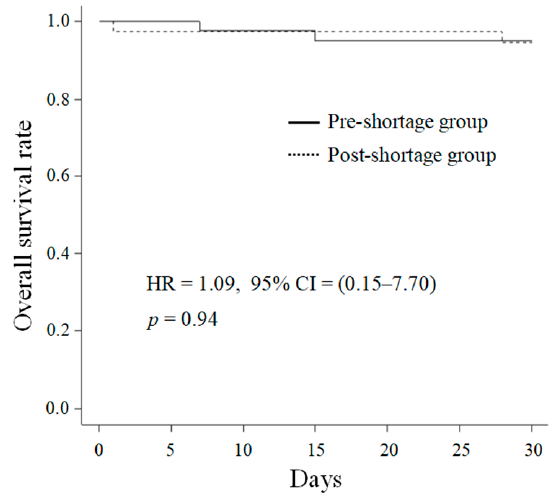
Figure 1. Kaplan–Meier survival curves of pre- and post-shortage groups.